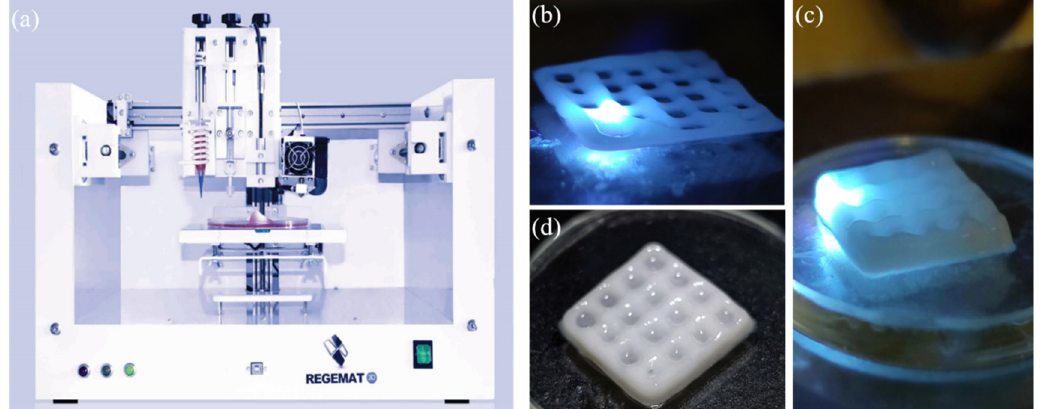
Figure 1. Semi-solid extrusion 3D printing. ( a ) Semi-solid extrusion 3D printer. Scaffolds printed with ( b ) 50% infill density, ( c ) 75% infill density, and ( d ) 100% infill density.